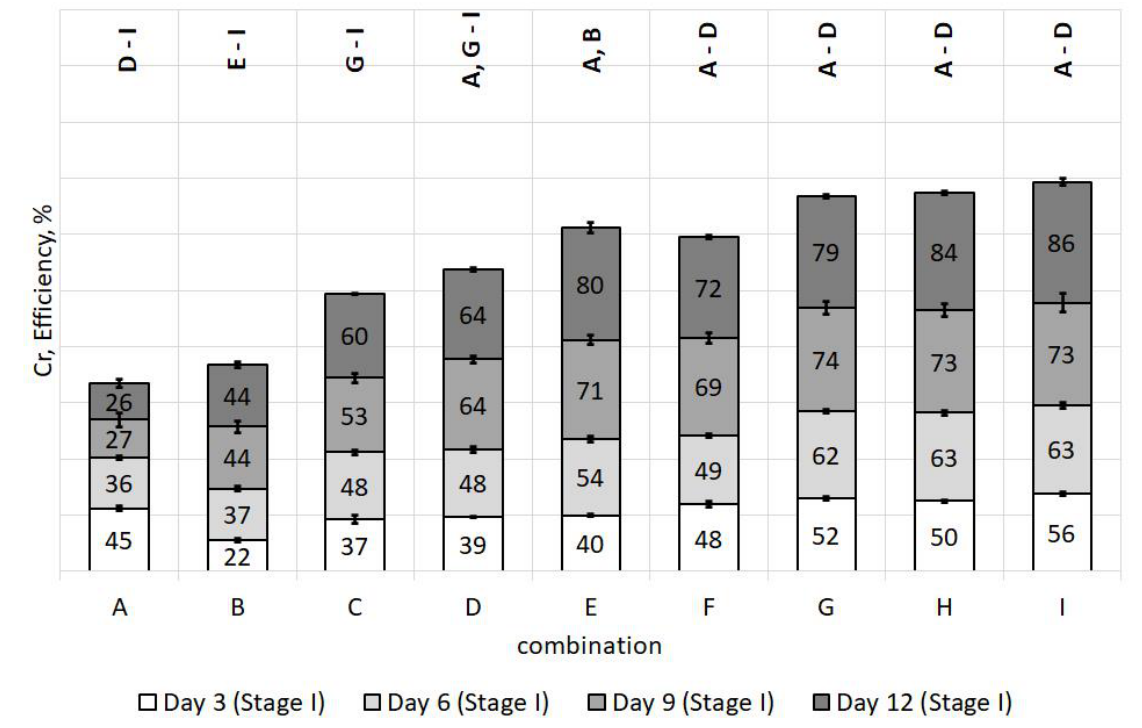
Figure 9. Effectiveness of Cr release to the dissolved fraction of leachate (Stage I).